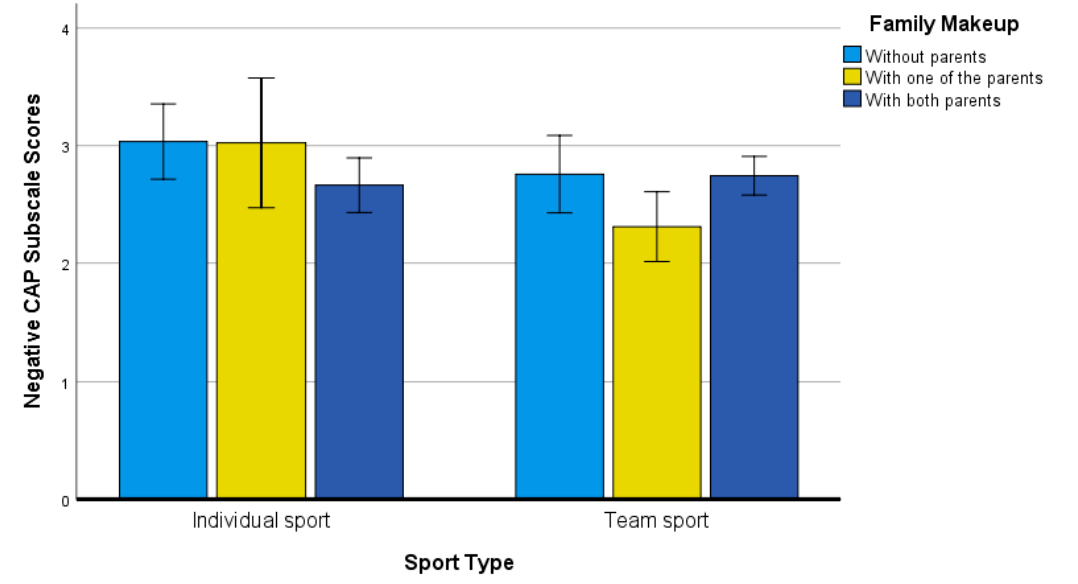
Figure 3. Negative CAP Subscale Scores for Sport Type and Family Makeup Groups.